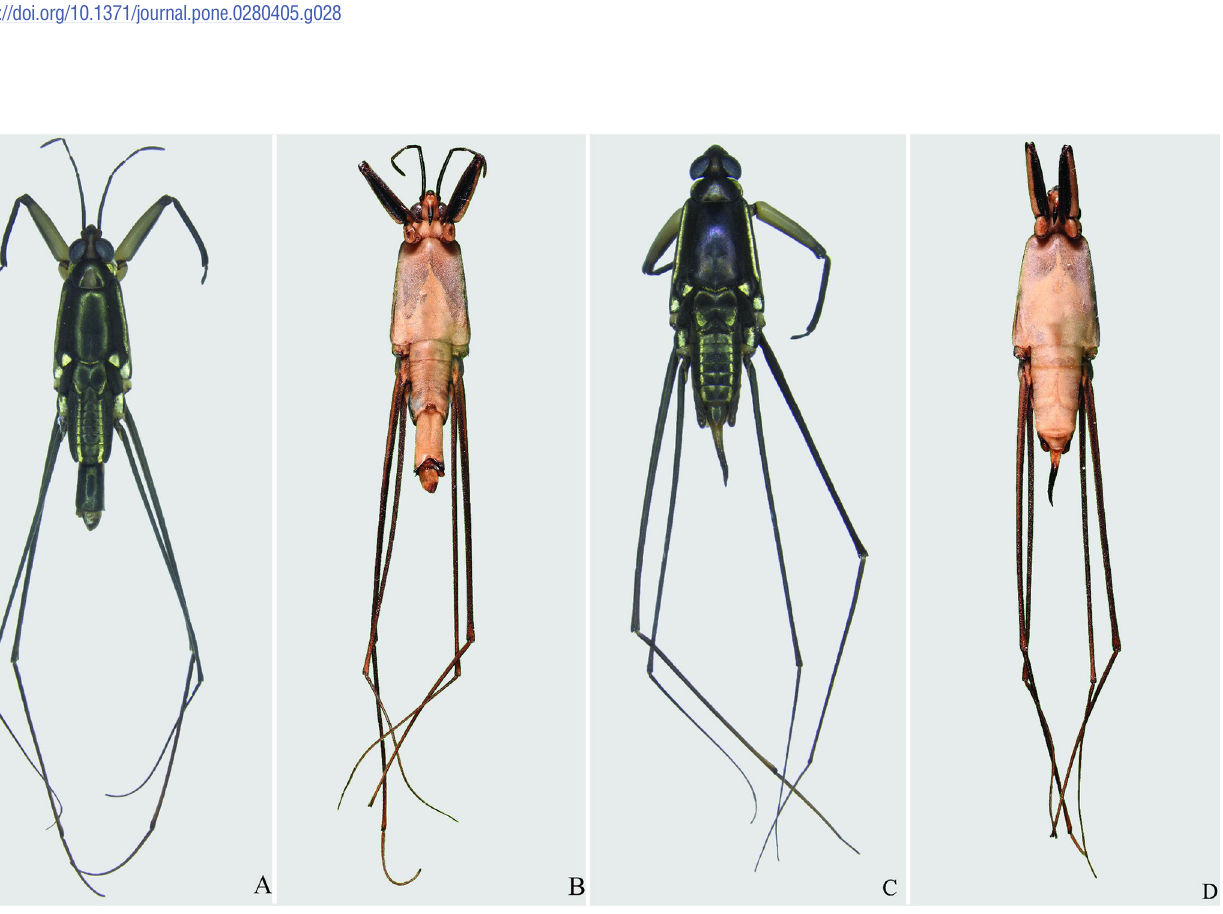
Fig 29. Potamobates molanoi sp new. (A) Male, dorsal view; (B) male, ventral view; (C) female, dorsal view; (D) female, ventral view.